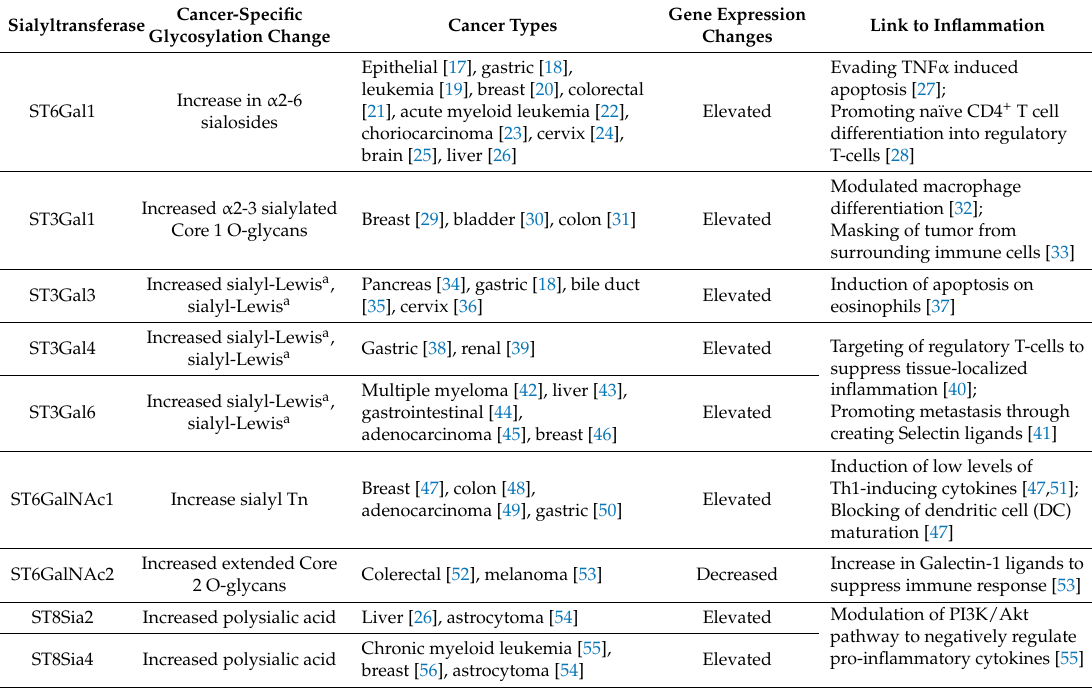
Table 1. Altered sialyltransferase expression in cancer and its relation to